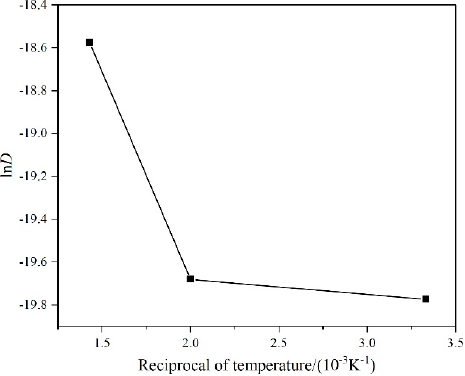
Figure 4. Diffusion coefficients of water molecules in ( a ) oil-water system model at different tem- peratures; ( b ) oil-water-acid system model at different aging acid concentrations.